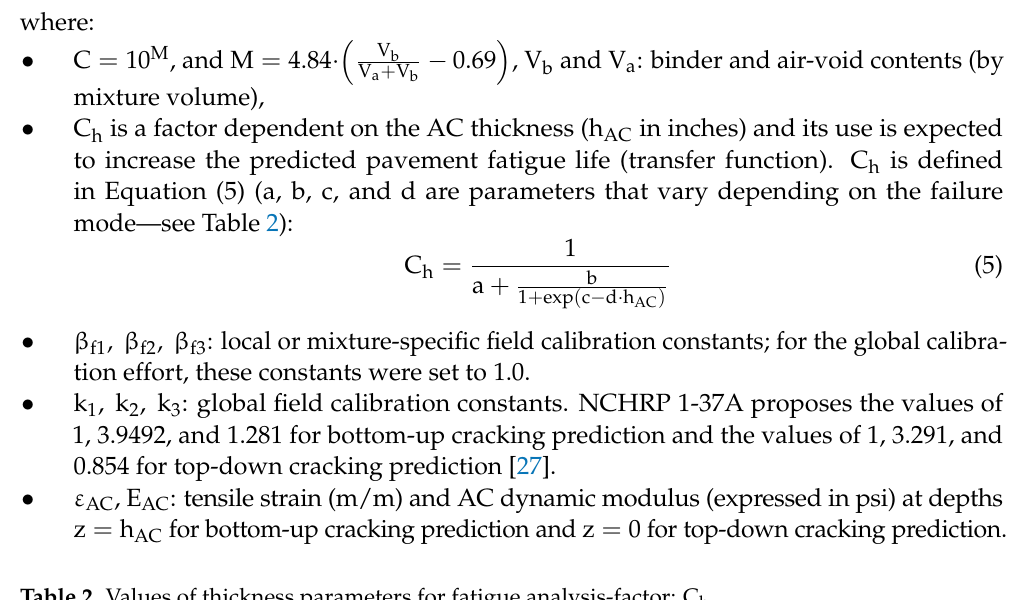
Table 2. Values of thickness parameters for fatigue analysis-factor: C h . Failure Mode a b c d Bottom-up cracking 0.000398 Top-down cracking